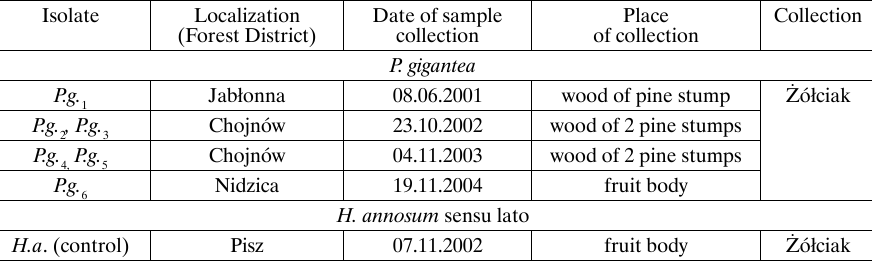
The isolates of P. gigantea and H. annosum sensu lato used in the experiment